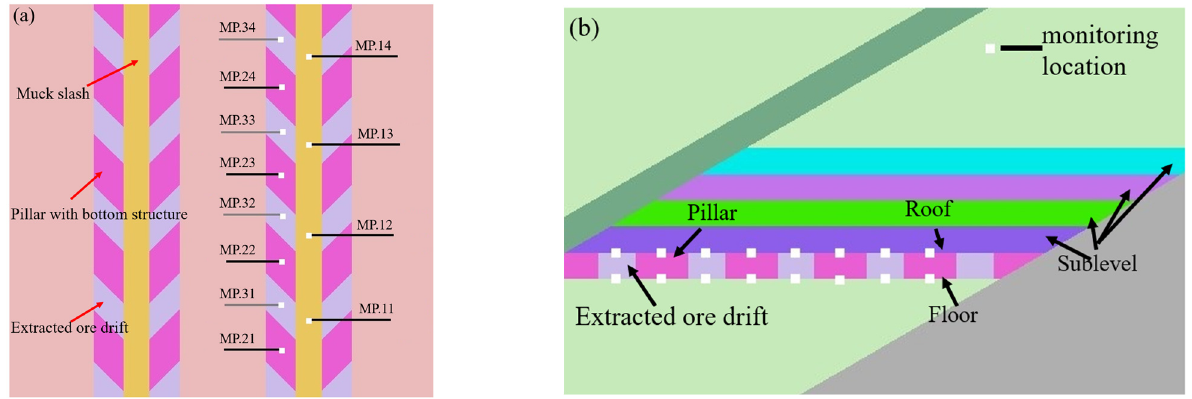
Figure 8. Distribution of monitoring points. ( a ) Top view of MP layout ( b ) Side view of MP layout.